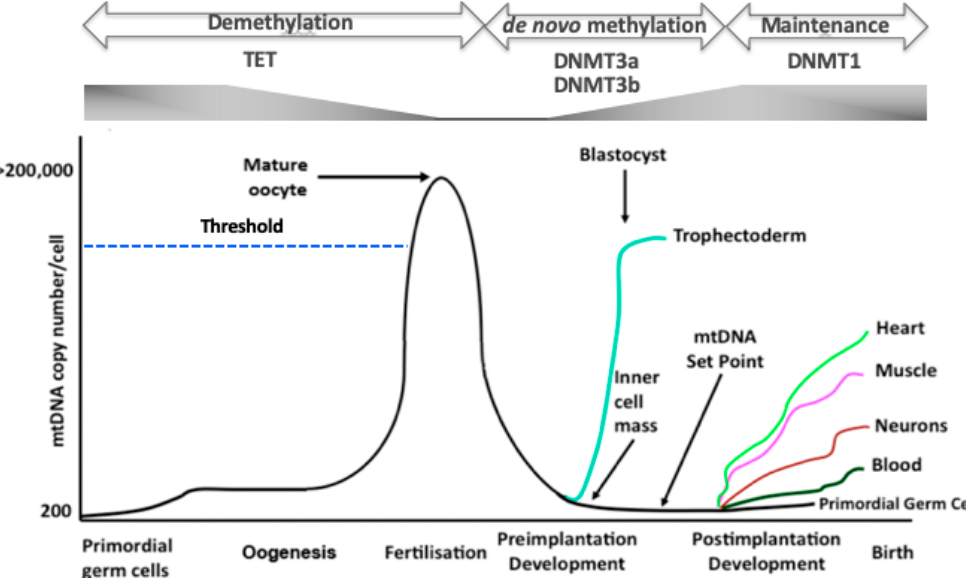
Figure 2. The regulation of mtDNA copy number during development. In primordial germ cells, mtDNA is maintained at low levels. As oogenesis progresses, mtDNA copy number increases significantly and is then arrested at the metaphase II stage. A threshold (broken blue line) needs to be reached in order that oocytes mature and fertilize. Following fertilization, mtDNA copy number decreases through to the blastocyst stage. mtDNA replication is initiated in the trophectoderm, whilst the ICM continues to reduce mtDNA copy number. This enables the developing embryo to establish the mtDNA set point prior to differentiation. Following commitment to a specific lineage, cells then replicate their mtDNA in a cell-specific manner to enable them to perform their specialized functions through OXPHOS, as required. Furthermore, there are synchronous changes to DNA methylation and gene expression profiles throughout these processes. TET enzymes reduce parental DNA methylation through to the blastocyst stage whilst de novo DNA methylation, mediated by DNMT3a and DNMT3b, is initiated in the blastocyst. DNMT1 then maintains the newly established cell-specific DNA methylation profiles.